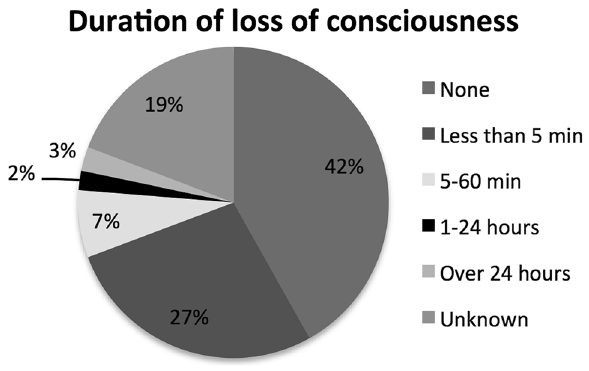
Figure 2. Duration of loss of consciousness following head injury.